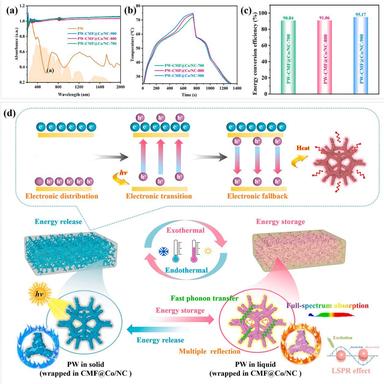
(a) UV–Vis-NIR absorption spectra; (b) Solar-thermal conversion curves; (c) Energy conversion efficiency; (d) the reinforced photothermal mechanism illustration.